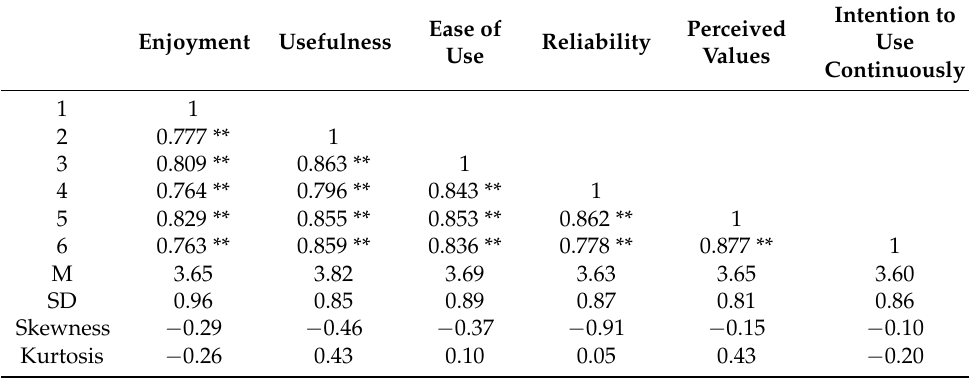
Table 4. Descriptive statistics and correlation analysis.